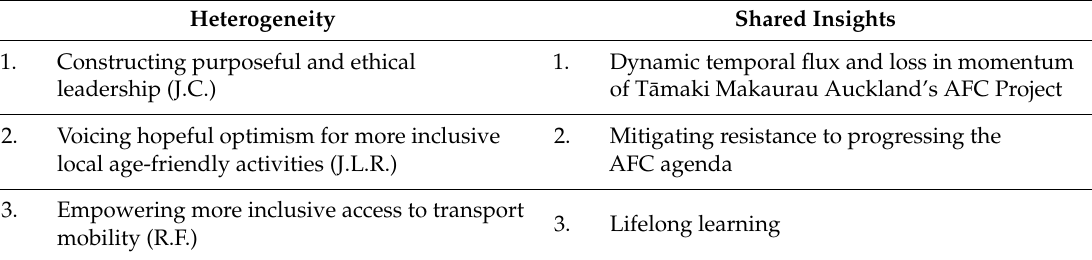
Table 4. Heterogeneity and shared insights in the relational leadership interview